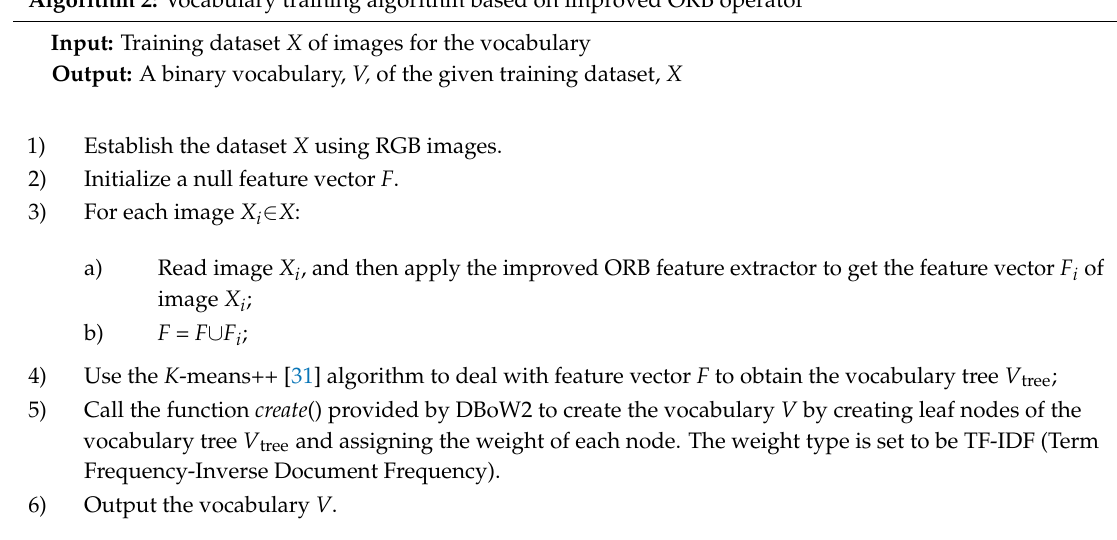
Algorithm 2: Vocabulary training algorithm based on improved ORB